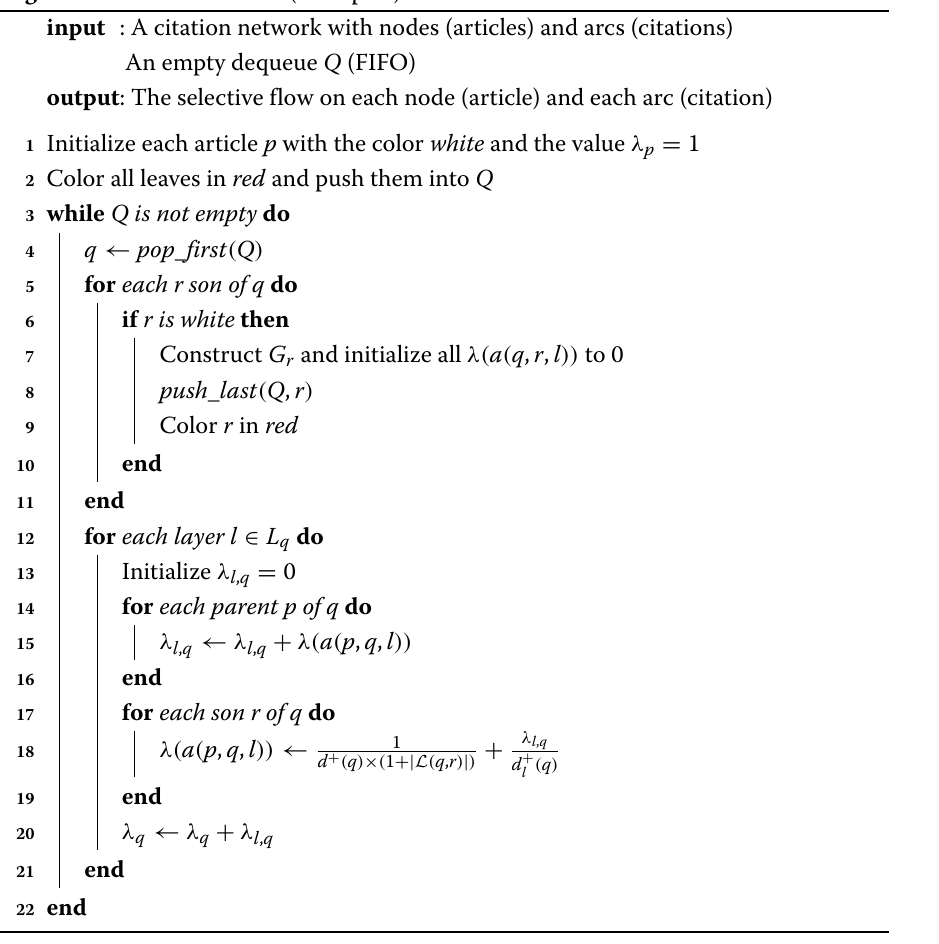
Algorithm 4: Selective flow